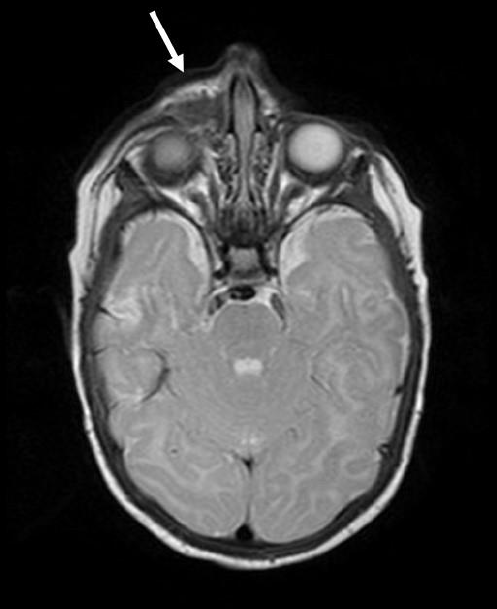
Figure 4. Patient 1: an axial T2-weighted MR scan shows recurrence of MNTI in the postoperative area. Table 1. Chemotherapy in patient 1.